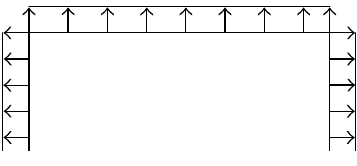
Figure 2.1. Viscoelastic half-space under initial hydrostatic stress in presence of temperature